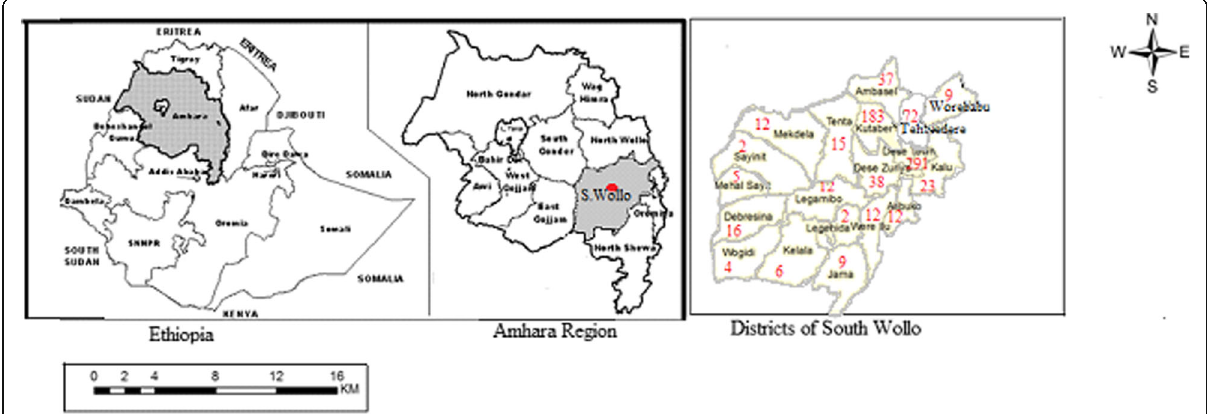
Fig. 1 Map of Ethiopia, Amhara Region, and South Wollo Zone Districts where from cutaneous leishmaniasis (CL) patients of Boru Meda Hospital originated. The figure inside each district indicates the number of CL cases . Since Dessie town and Kutaber are closer to the Hospital, more people are expected to be examined and correspondingly more are CL-positive. So, unless the number of people examined is known it may be misleading to conclude that the highest number and proportion of CL were from these